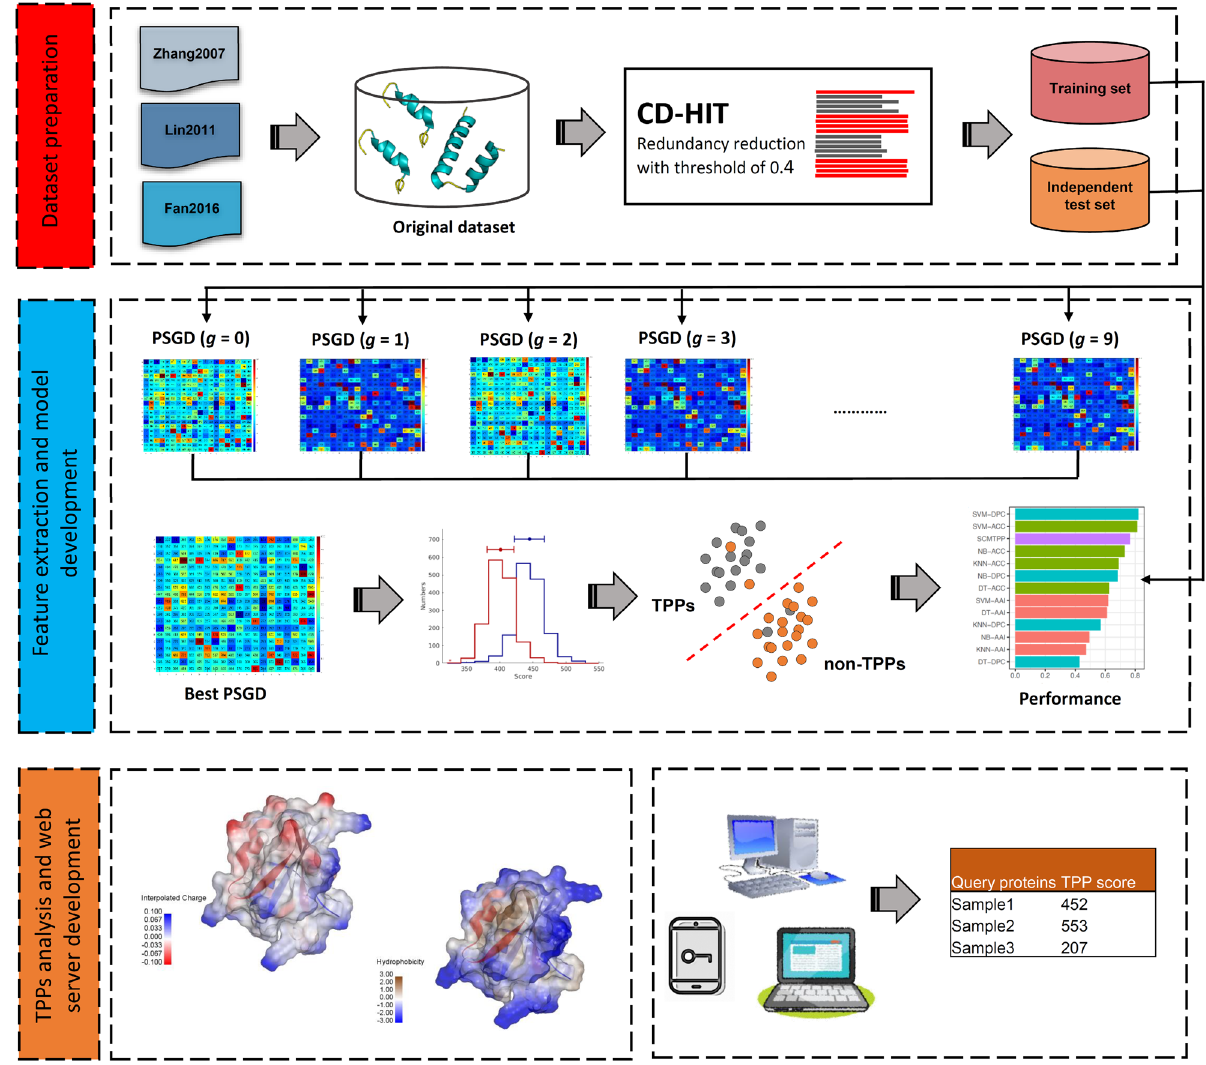
Figure 1. Schematic framework of the development of SCMTPP. This can be summarized into five main steps: (i) Training and independent test datasets preparation, (ii) Feature extraction, (iii) SCM-based model development, (iv) TPPs characterization and (v) SCMTPP webserver